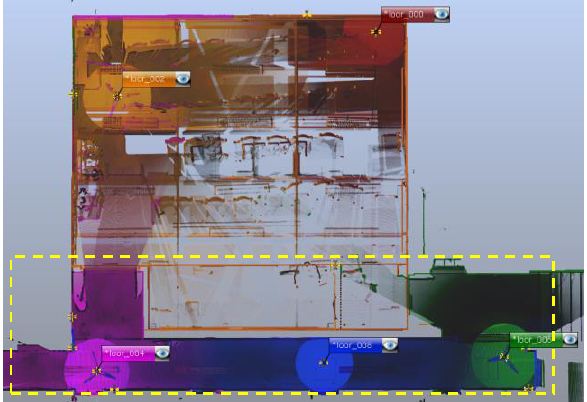
Figure 5. Faro scan positions after registration in Faro Scene; yellow dashed box indicates final cropped benchmark area The global coordinate system origin was placed at the scan origin in scan 008 in the centre of the corridor. The coordinates of the scan positions relative to this are shown in Table 1 along final cropped dataset. Along with the coordinates, intensity data